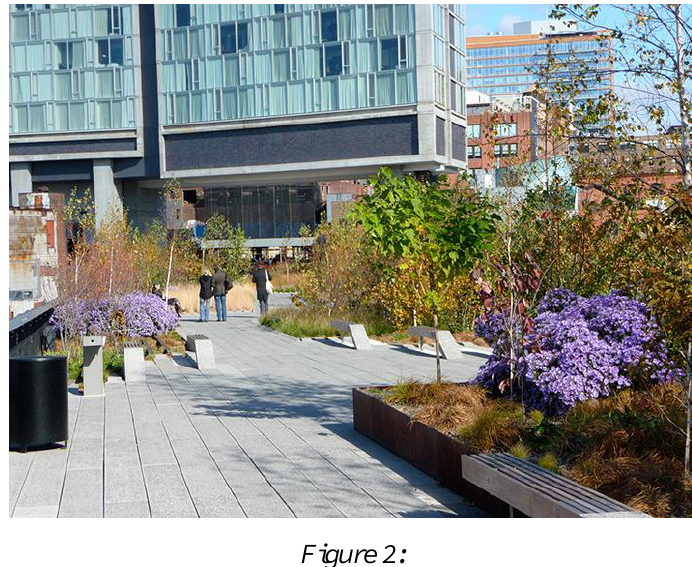
High Line Experience. (photograph by the